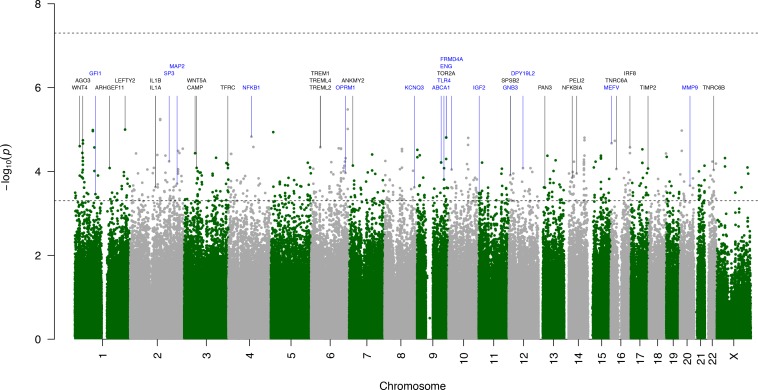
Manhattan plot for maternal GWAS of gestational age in labor-initiated deliveries.In total 1 407 genomes were analysed. Each SNP was assigned the most extreme empirical p-value from the three genetic models (additive, recessive, dominant). The top line indicates a genome-wide significance level (5×10−8), while the bottom line marks a significance level (5×10−4) determining the number of “clumps” (independent loci that were used in gene-set enrichment analyses). Genes from gene-set enrichment analyses are marked in blue, while other biologically relevant genes (from the literature-informed analyses) are marked in black.